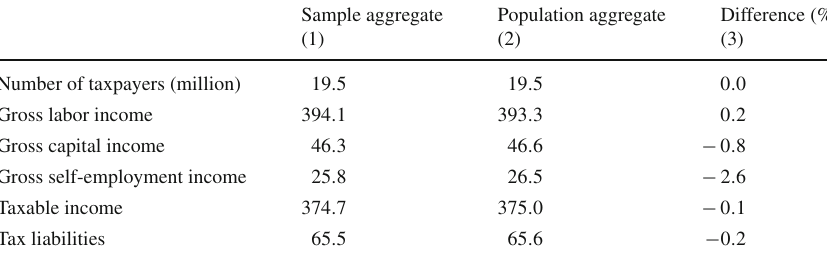
Table 2 Accuracy of the 2015 cross section data ( e Billion) Sample aggregate Population